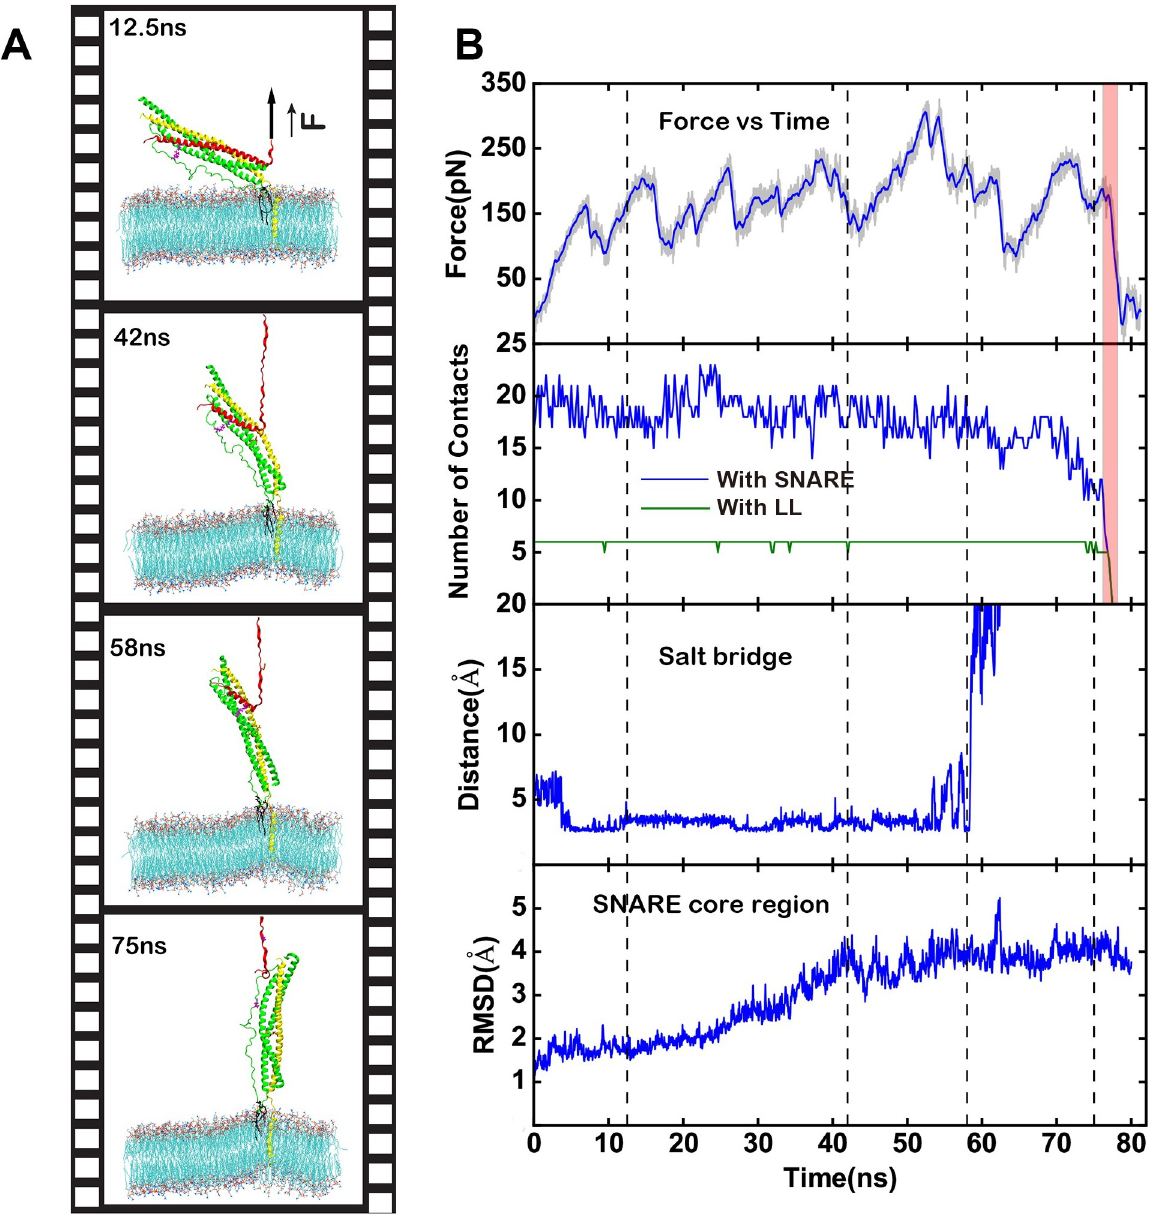
Fig 5. Steered molecular dynamics simulations. (A)Snapshots for a representativeunzipping simulation(FU2). (B)First panel:the force curve. Second panel: the number of contacts betweenVAMP2 residues 25 to 41 with SNAP 25. Third panel: the distancebetween VAMP2 E41 and SNAP25 R124 salt bridge. Fourth panel: the RMSD of the rest part of SNARE core domain when VAMP2 is pulled away. The pink area indicatedthe final detachmentbetween VAMP2 and the rest of SNARE core domain, four dashedline represents the time of snapshots in (Fig